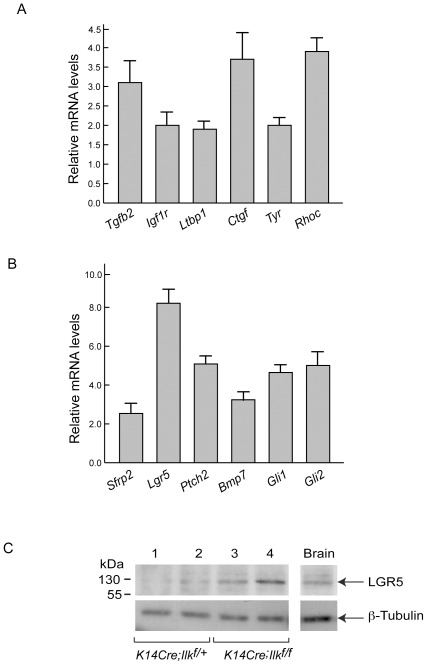
Altered expression of genes encoding growth factors and developmental regulators in ILK-deficient epidermis.(A, B) Expression levels of selected transcripts encoding proteins associated with growth factors or pigmentation (panel A), or key factors in developmental epidermal pathways (panel B) in ILK-deficient K14Cre-Ilkf/f epidermis, determined by qPCR. The results are expressed as the mean+SEM (n = 5). The differences in expression in ILK-deficient epidermis for each of transcripts shown reached statistical significance (P<0.001, Student's t test) relative to the corresponding transcript levels in ILK-expressing K14Cre-Ilkf/+ epidermis (set to 1). (C) Protein lysates prepared from the skin of 3 day-old K14Cre-Ilkf/f or K14Cre-Ilkf/+ mice (two animals of each genotype) were resolved by denaturing gel electrophoresis, followed by immunoblot analysis using antibodies against LGR5, or γ-tubulin, used as loading control. Lysates prepared from wild type mouse brain were used as a positive control for LGR5 expression.